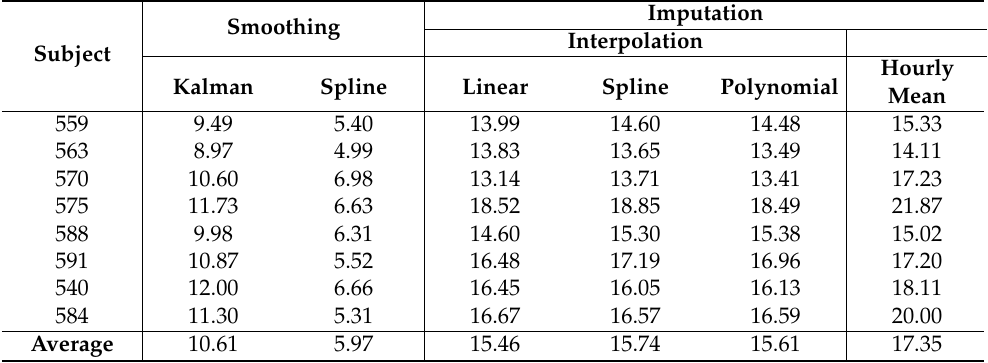
Table 9. Average RMSE for predicting glucose level using bivariate (CGM and meal) Transformer after imputation